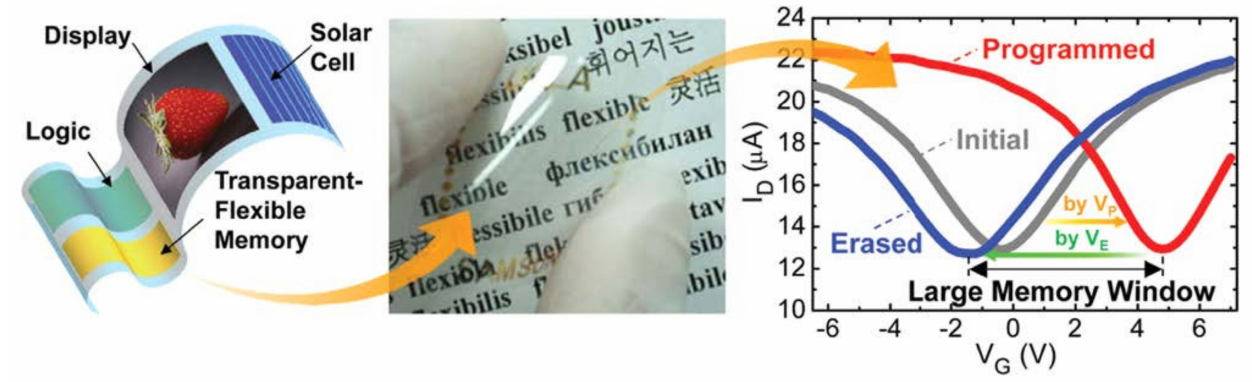
Figure 10. ( Left ) FTM can be utilized for transparent and flexible electronics that require integration of logic, memory, and display, on a single substrate with high transparency and endurance under stress. ( Middle ) Photograph of the large-scale transparent–flexible FTM array fabricated on PEN substrate. FTM cell is transparent enough to see objects through it without image distortion flex. ( Right ) Memory characteristics of FTM. (Reproduced with permission from ref